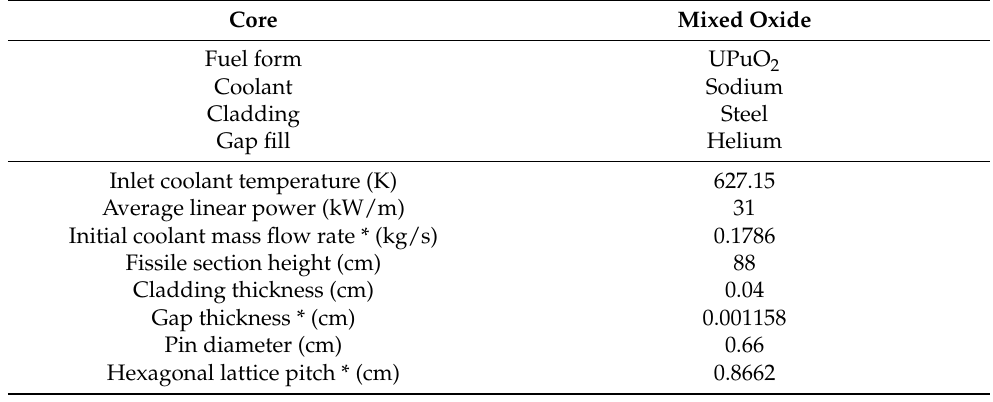
Table 1. Design parameters for the mixed oxide reactor based on a BN-800 reactor [33]. * corresponds to calculated values.